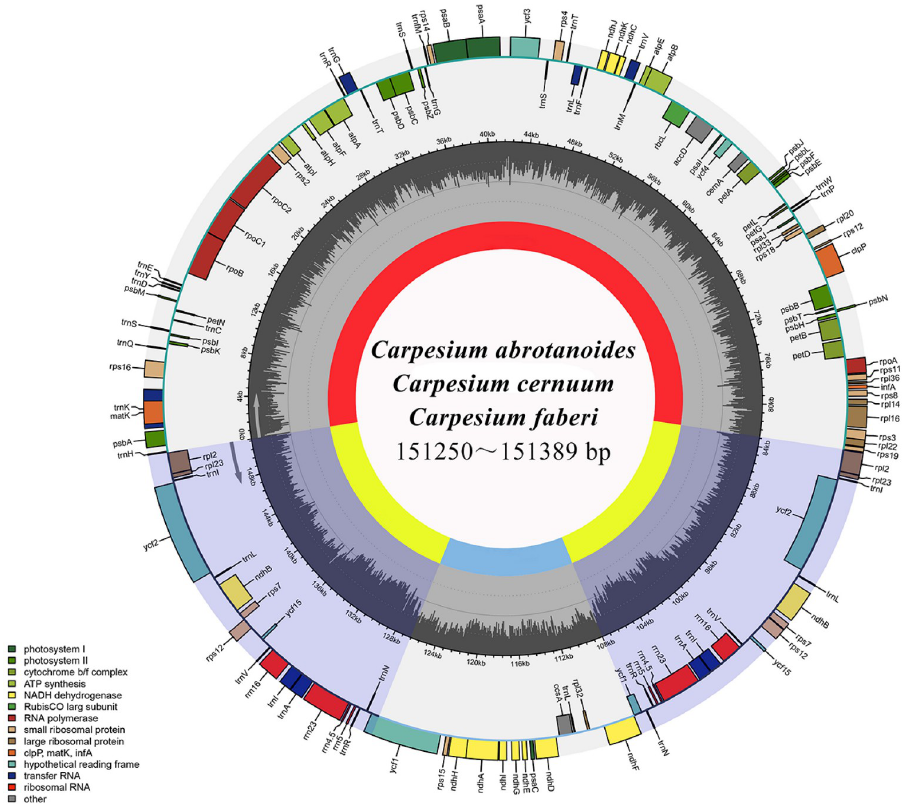
Fig 1. Cp genome mapping of three Carpesium species. The inner genes are transcribed clockwise, and the outer genes are transcribed counterclockwise. Different colors indicate genes with different functions. The light black of the inner circle indicates GC content, and dark gray indicates AT